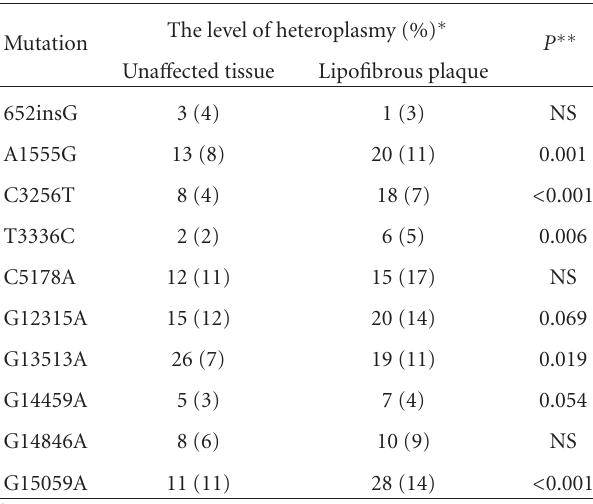
Table 1: Comparison of the level of heteroplasmy for ten mitochon- drial mutations in homogenates of una ff ected intimal samples and atherosclerotic